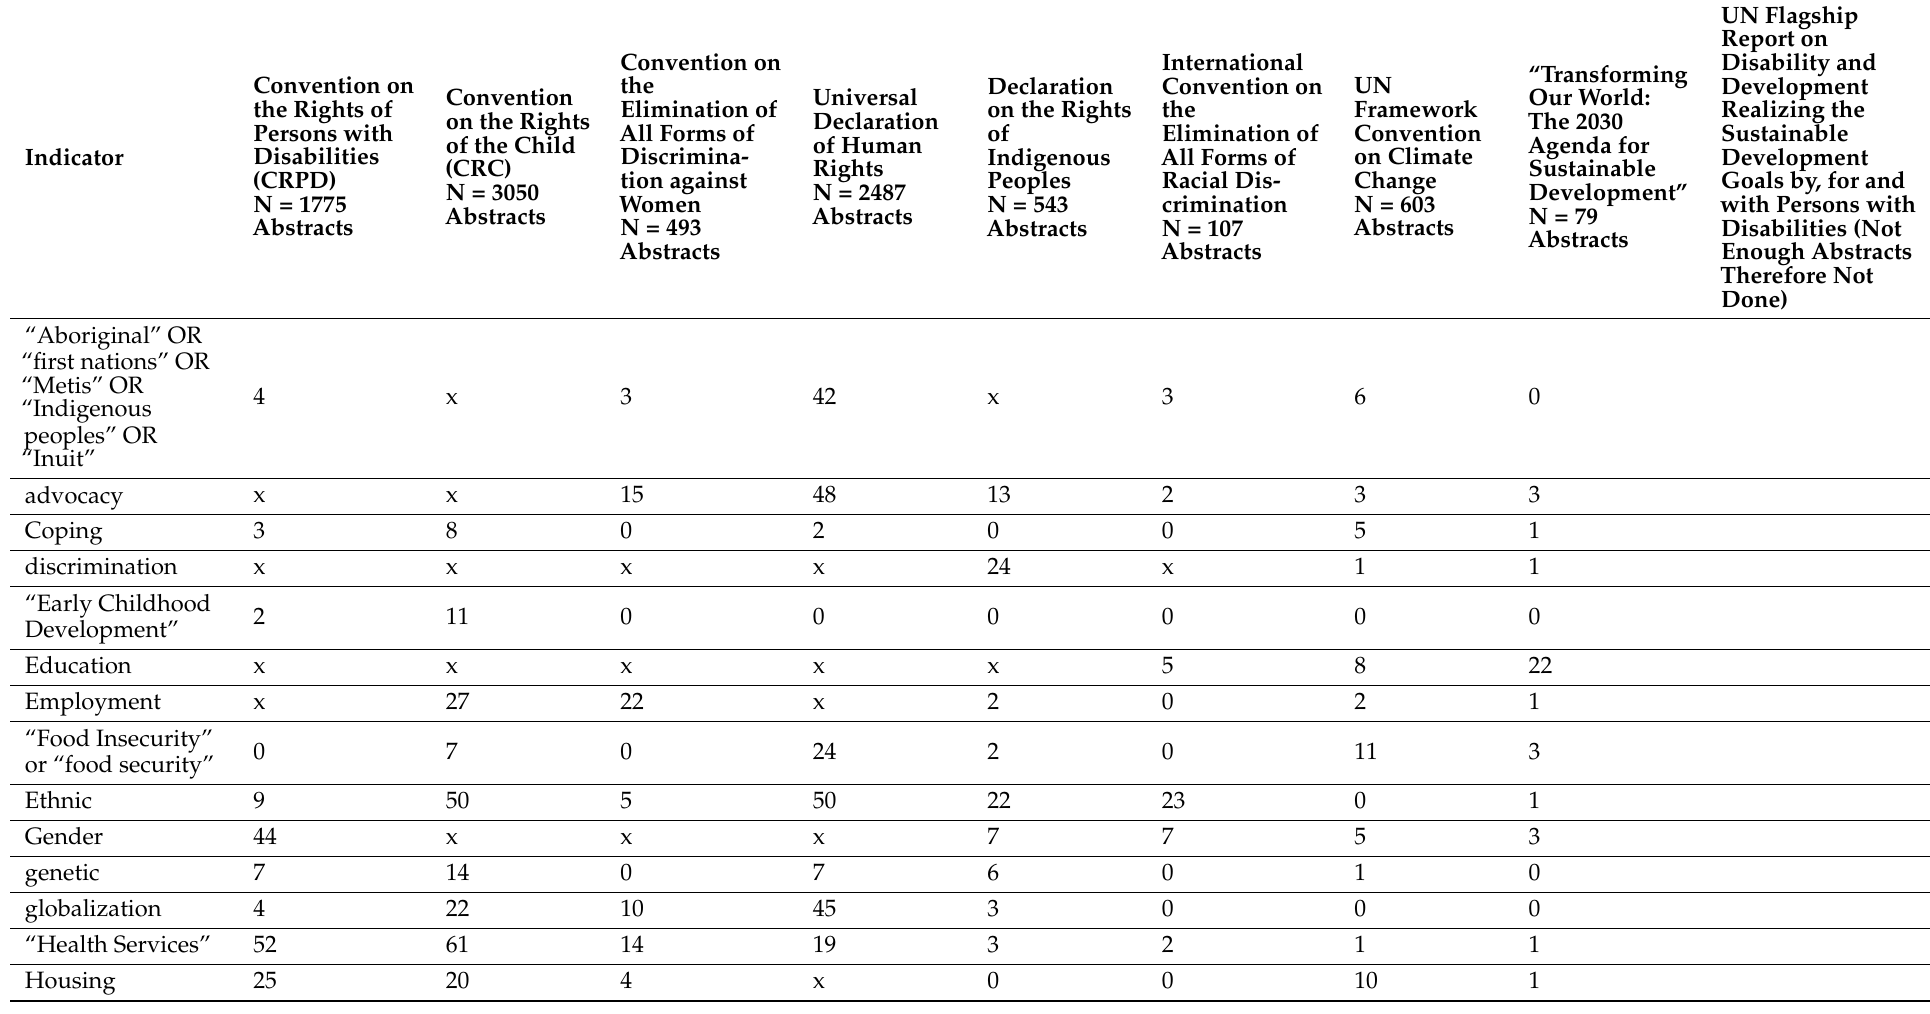
Table 14. Presence of Social determinants of health (SDH) indicators in abstracts mentioning “the